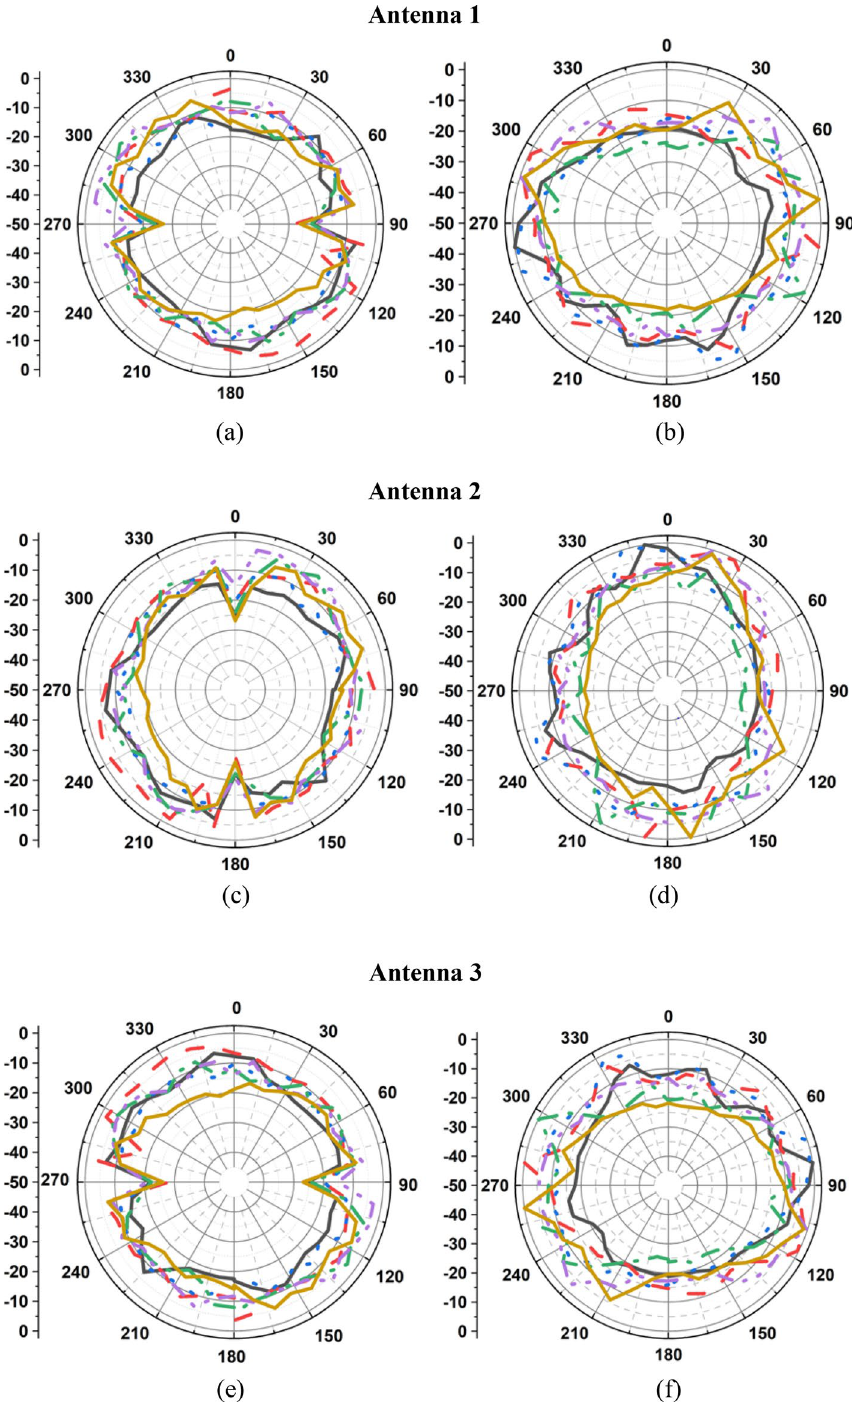
Figure 11. Measured radiations pattern at 1.8 GHz, 2.4 GHz, 3.1 GHz, 5 GHz, 6.8 GHz, 8.5 GHz: ( a ) E-plane/ yz / φ = 90°, ( b ) H-plane/ xz / φ = 0°, ( c ) E-plane/ yz / φ = 90°, ( d ) H-plane/ xz / φ = 0°, ( e ) E-plane/ yz / φ = 90°, ( f ) H-plane/ xz / φ = 0°, ( g ) E-plane/ yz / φ = 90°, ( h ) H-plane/ xz / φ = 0°, ( i ) E-plane/ yz / φ = 90°, ( j ) H-plane/ xz / φ = 0°, ( k ) E-plane/ yz / φ = 90°, ( l ) H-plane/ xz / φ = 0°, ( m ) E-plane/ yz / φ = 90°, ( n ) H-plane/ xy / φ = 0°, ( o ) E-plane/ xz / φ = 90°, ( p ) H-plane/ xy / φ = 0°, ( q ) E-plane/ yz / φ = 90°, ( r ) H-plane/ xy / φ = 0°, ( s ) E-plane/ xz / φ = 90°, ( t ) H-plane/ xy / φ = 0°, ( u ) E-plane/ yz / φ = 90°, ( v ) H-plane/ xy / φ = 0°, ( w ) E-plane/ xz / φ = 90°, ( x ) H-plane/ xy / φ =